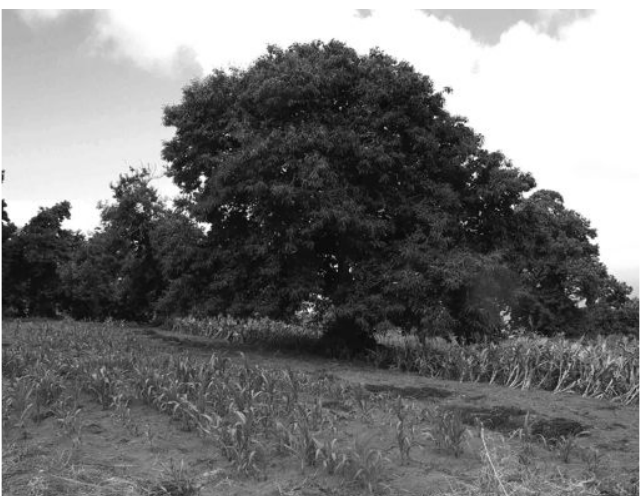
Fig. 3 - Chestnut-corn association.